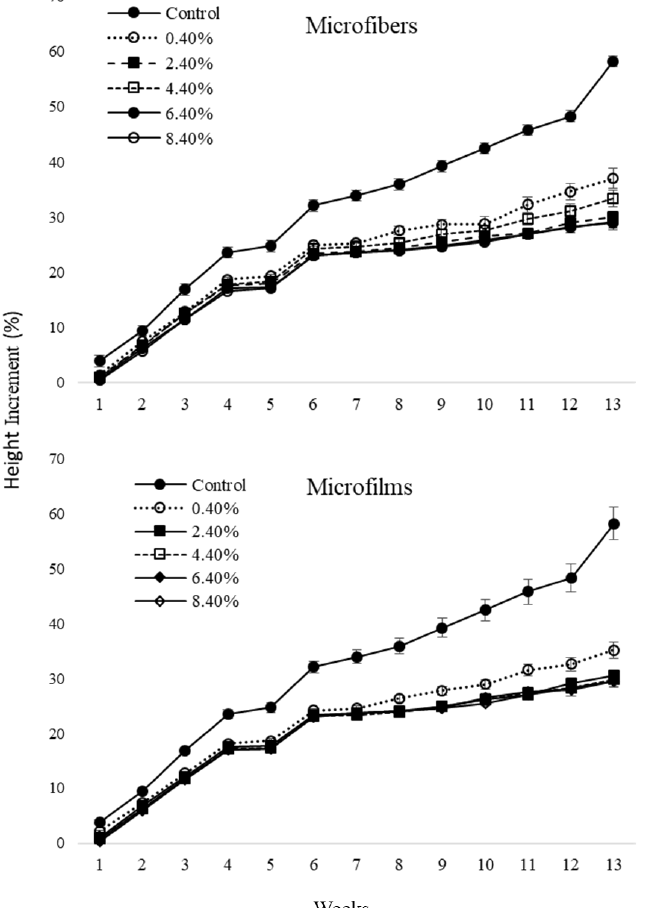
Figure 1: Weekly average height increments (%) of S . lycopersicum plants grown under different concentrations of microfiber and microfilm (0.4, 2.4, 4.4, 6.4, and 8.4% w/w) for a period of thirteen weeks. In control pots, plants were grown without MPs. Error bars are standard errors of means